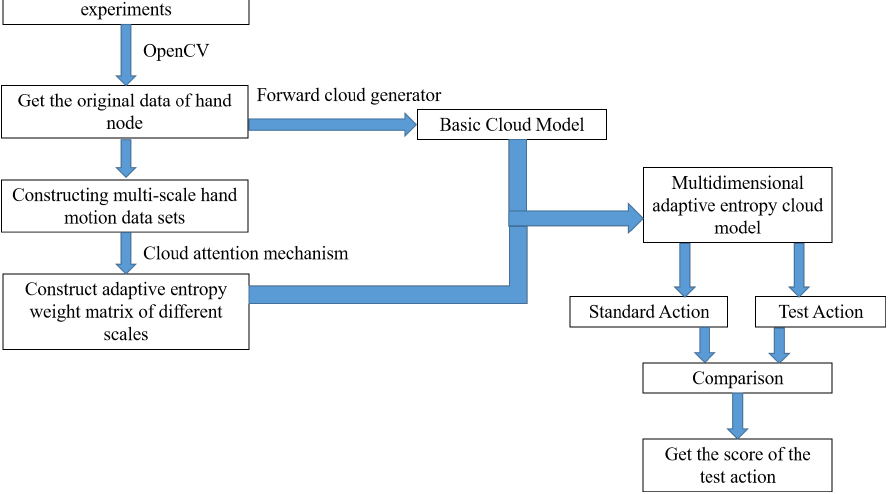
Figure 1. Detailed flow chart of action